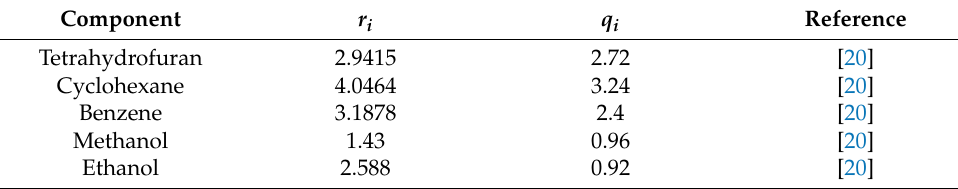
Table 2. Structural parameters for the UNIQUAC